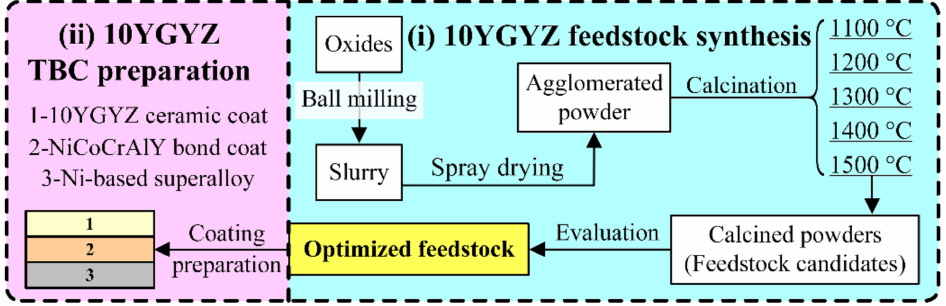
Figure 1. Research route of this